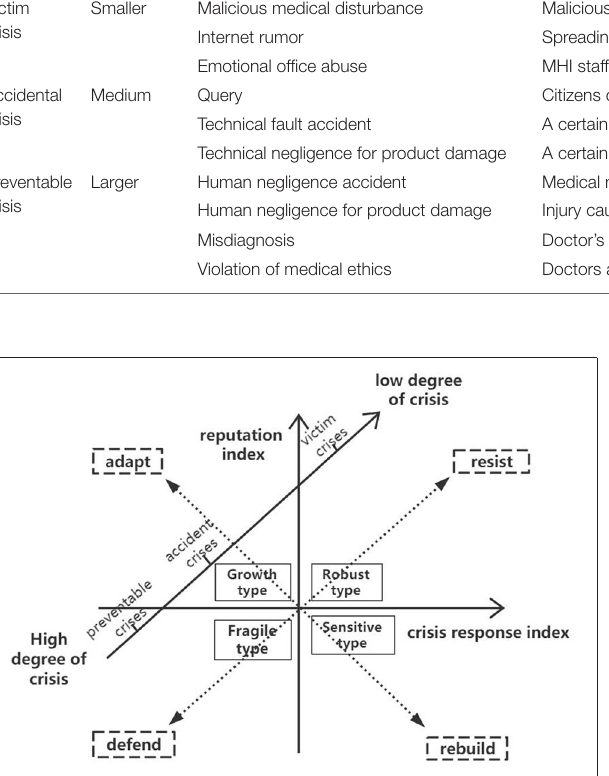
FIGURE 3 | Distribution chart of MHI reputation crisis management response strategy.